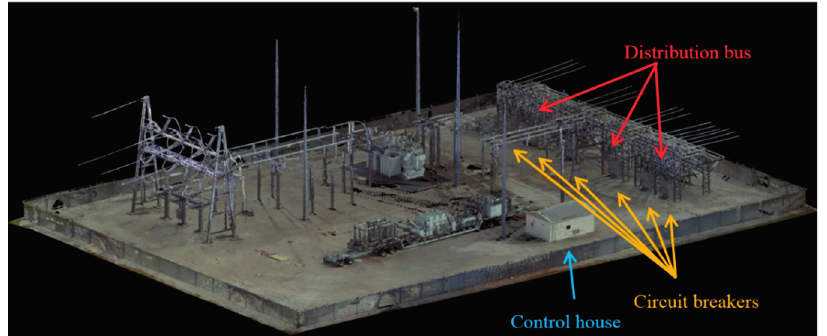
Figure 19. Third dataset, scanned by a Faro Focus terrestrial laser